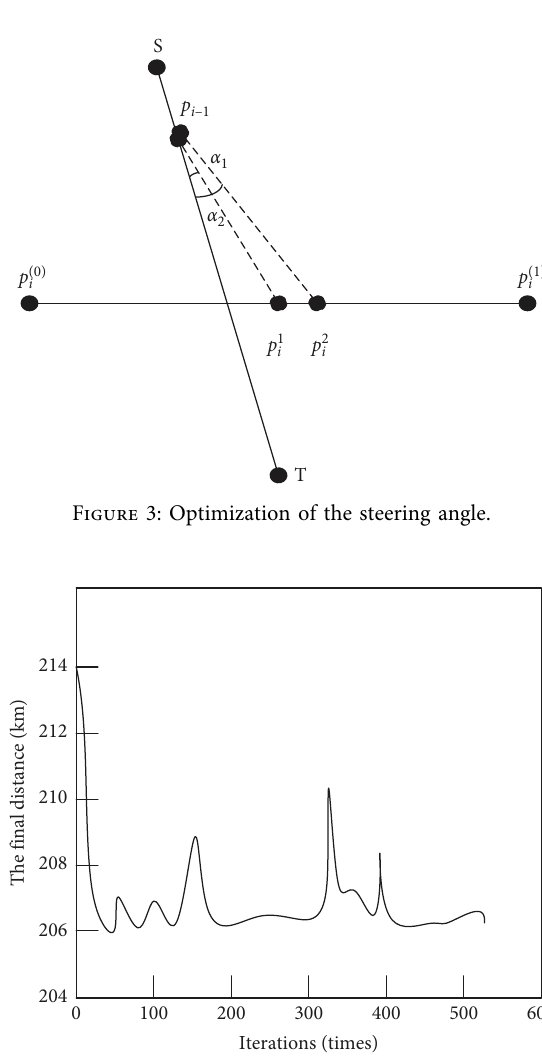
Figure 4: Convergence process of the ant colony algorithm. Table 2: Test